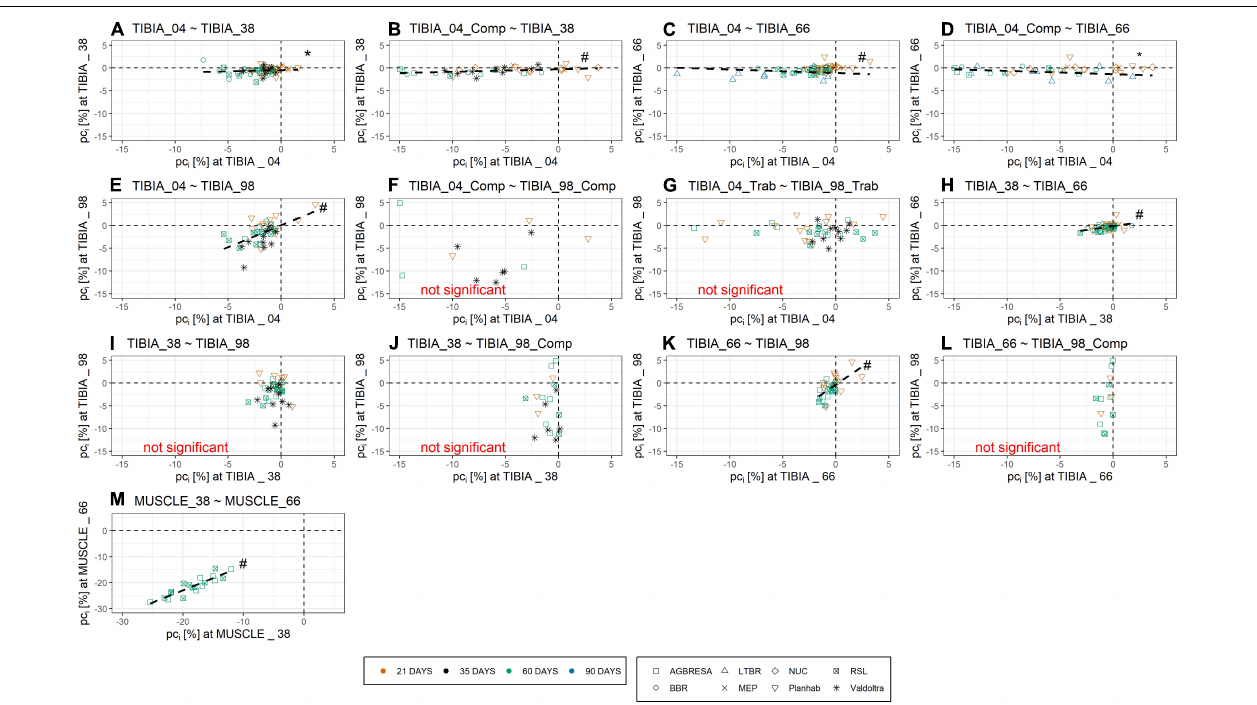
FIGURE 5 | Pearson Correlation of pc i of (A) TIBIA_04 and TIBIA_38, (B) TIBIA_04_Comp and TIBIA_38, (C) TIBIA_04 and TIBIA_66, (D) TIBIA_04_Comp and TIBIA_66, (E) TIBIA_04 and TIBIA_98, (F) TIBIA_04_Comp and TIBIA_98_Comp, (G) TIBIA_04_Trab and TIBIA_98_Trab, (H) TIBIA_38 and TIBIA_66, (I) TIBIA_38 and TIBIA_98, (J) TIBIA_38 and TIBIA_98_Comp, (K) TIBIA_66 and TIBIA_98, (L) TIBIA_66 and TIBIA_98_Comp, and (M) MUSCLE_38 and MUSCLE_66. Numbers indicate the relative measurement position regarding the entire tibia length from distal to proximal. Comp and Trab indicate compact and trabecular loss, respectively. The color indicates the bed rest duration and the shape represents the study. Several outliers are not shown in the figure due to graphical reasons, but are included in the linear regression analysis. Within the muscle sites, there was a strong positive correlation. The inter-site correlation of the bone sites ranged from no correlation to low positive correlation and moderate positive correlation. Strong positive correlation indicates no within-subject variation for the muscles, no correlation or low correlation indicates within-subject variation. Dashed line represents significant correlation. * denotes significant correlation with p < 0.01; # denotes significant correlation with p <